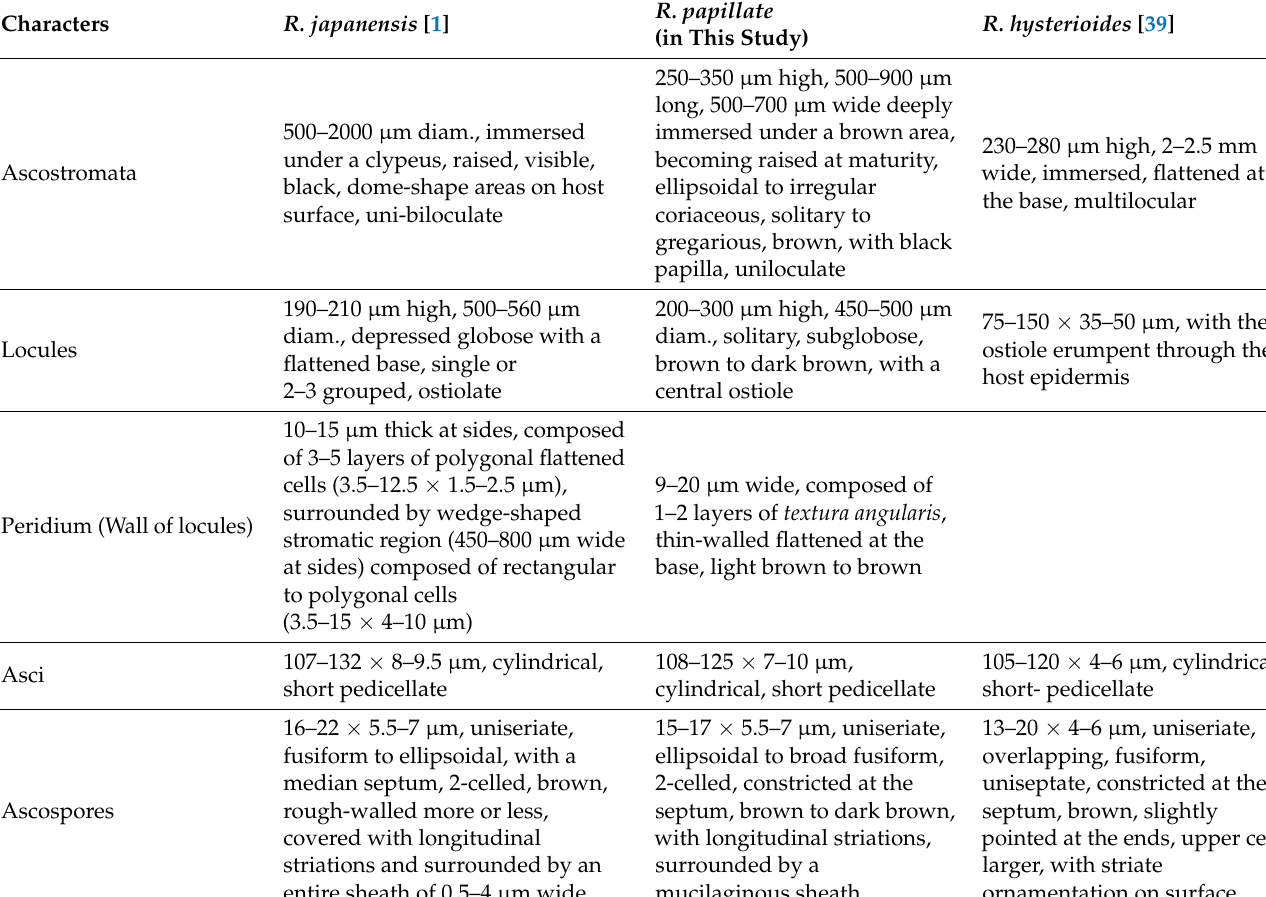
Table 5. Morphological comparison of R. papillate with R. hysterioides and R. japanensis